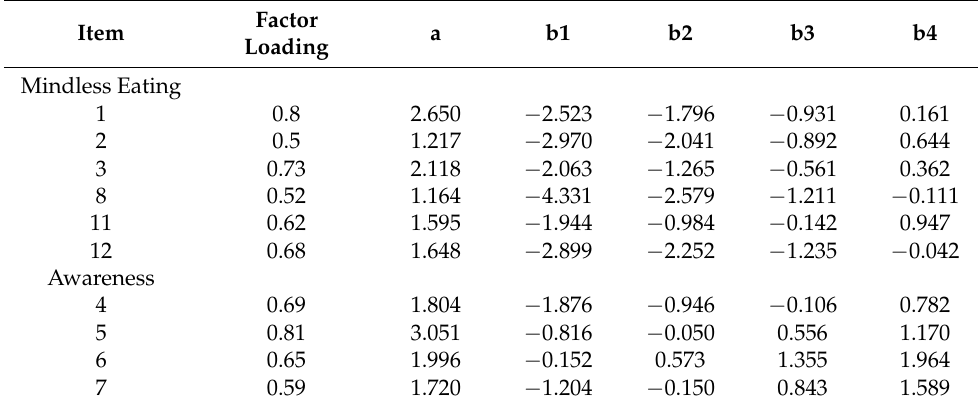
Table 3. Estimation of item parameters of discrimination and